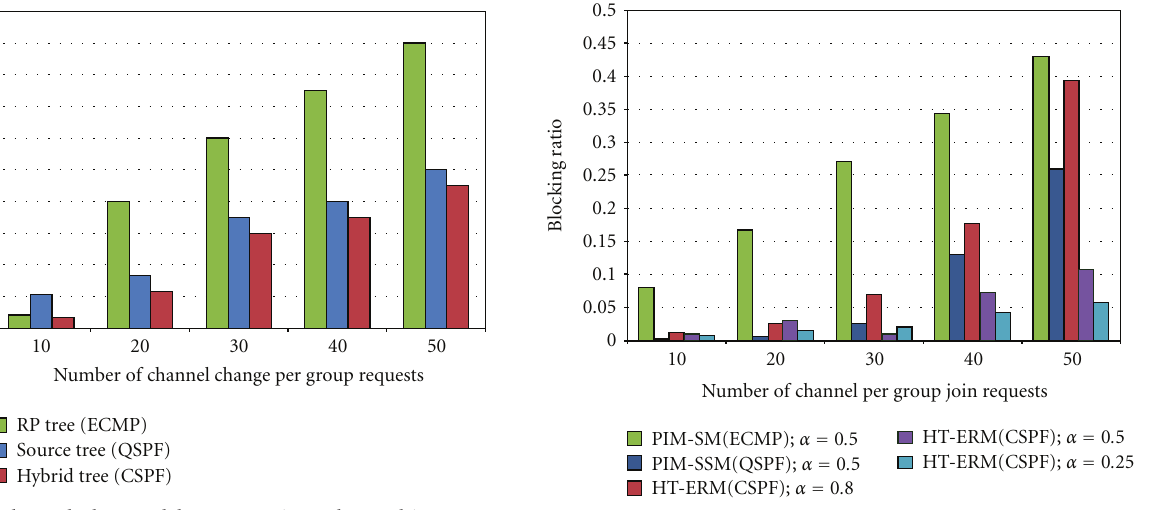
Figure 9: Channel change delay comparisons by multicast tree switching and transmission. Figure 10: Comparisons of blocking ratio for channel control.